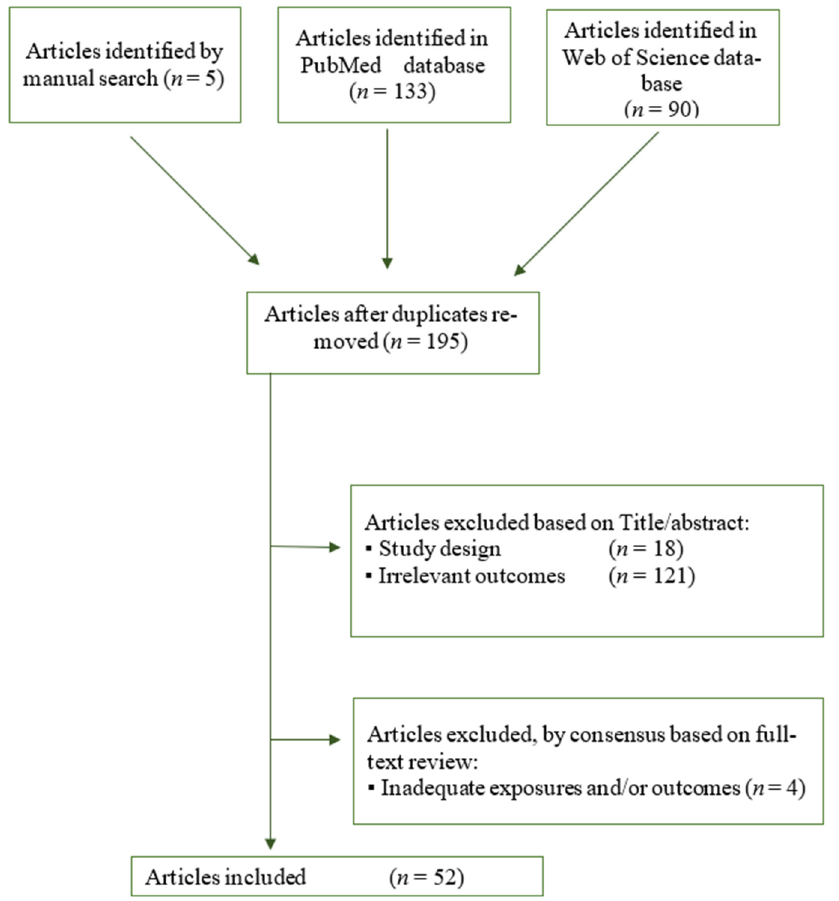
Figure 1. Flow diagram of the literature search and selection process.